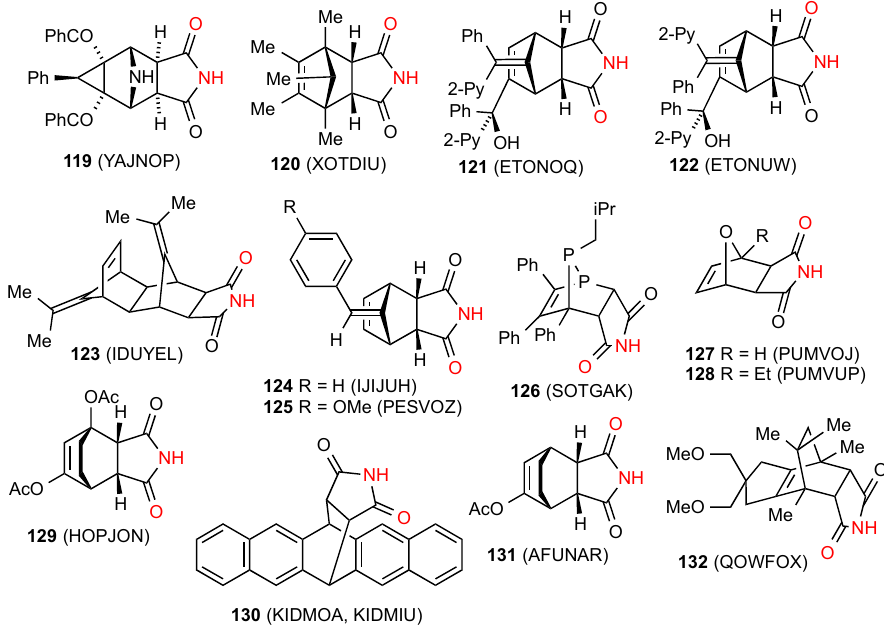
Figure 44. Bicyclo[2.2.1] and [2.2.2]-fused succinimides showing pattern A dimers. Crystals 2020 , 10 , x FOR PEER REVIEW